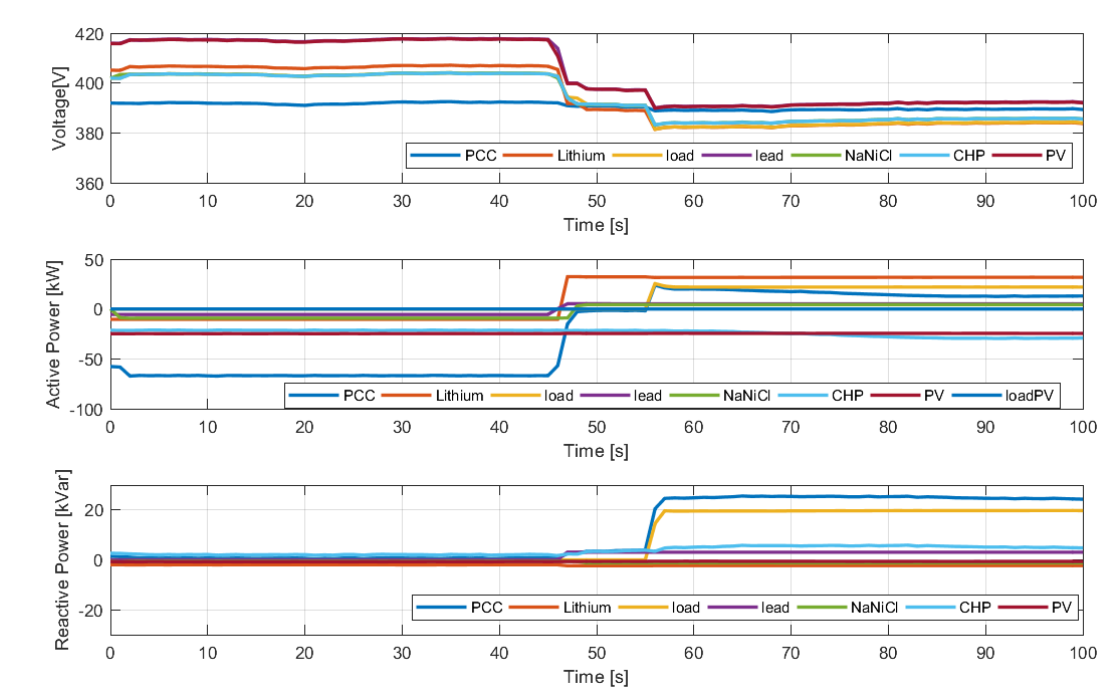
Figure 6. Voltage magnitudes in test system over time and active and reactive power outputs in overvoltage condition and with the control of all the resources.